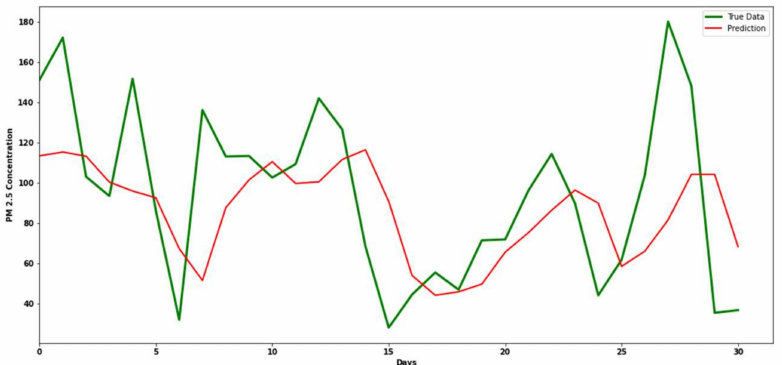
Figure 26. Forecasting for the next month for Karachi using the LSTM encoder–decoder